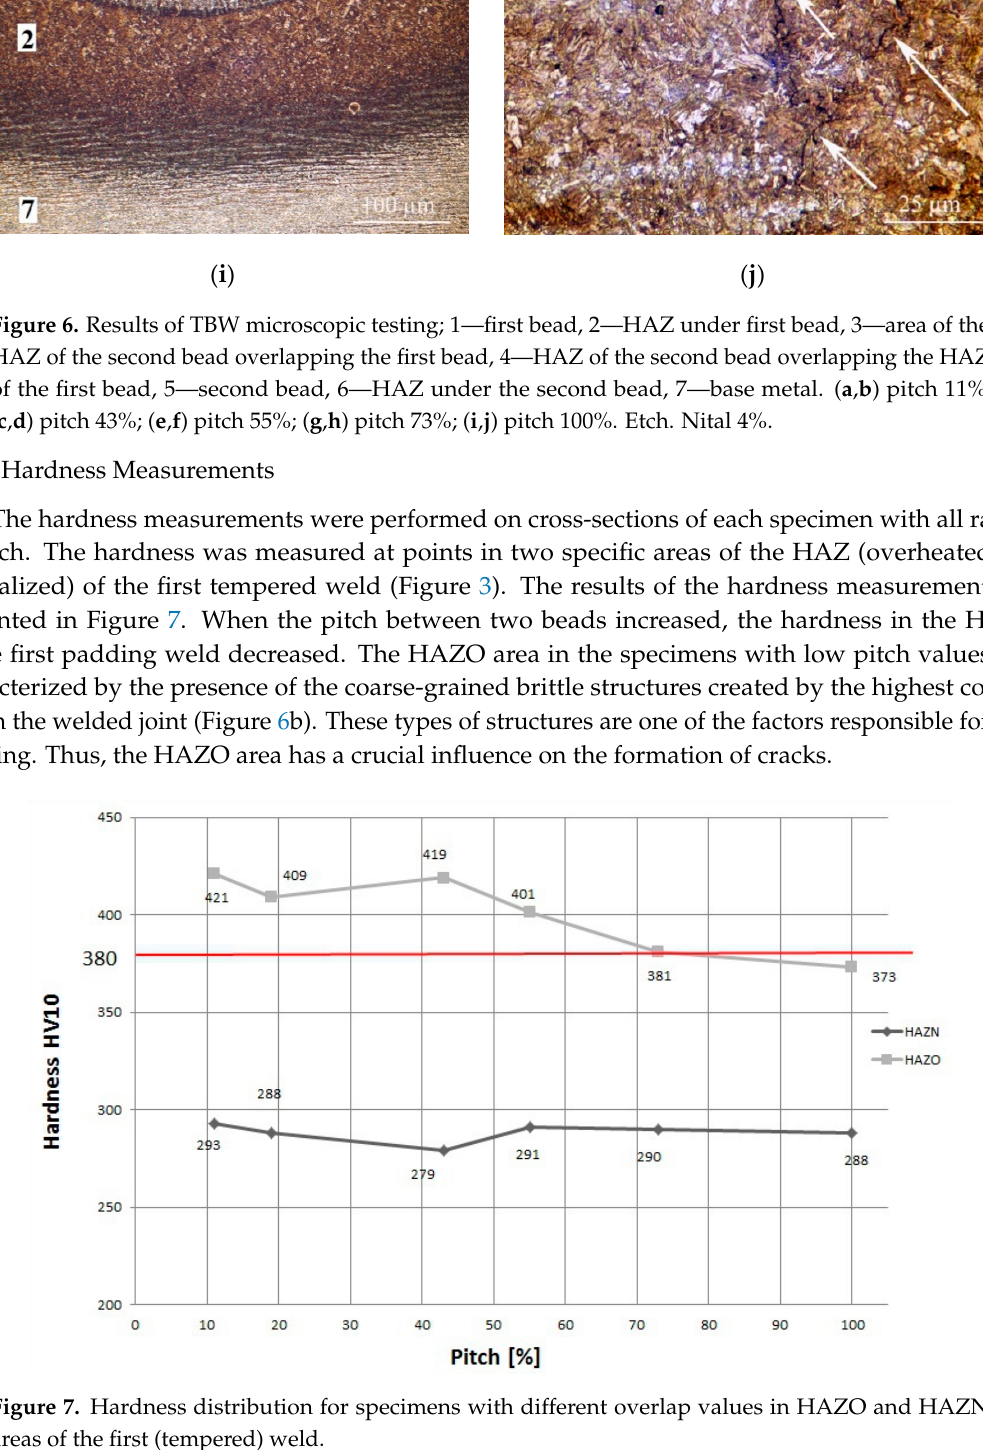
Table 6. Comparison of hardness HV10 for different steels for the TBW technique [25,26].